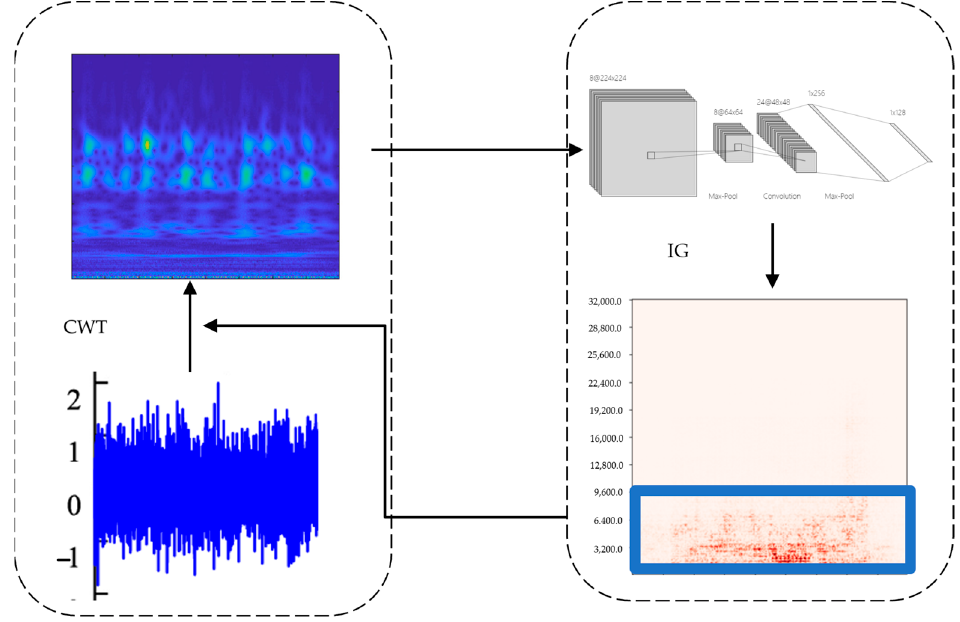
Figure 1. Framework of IG ‐